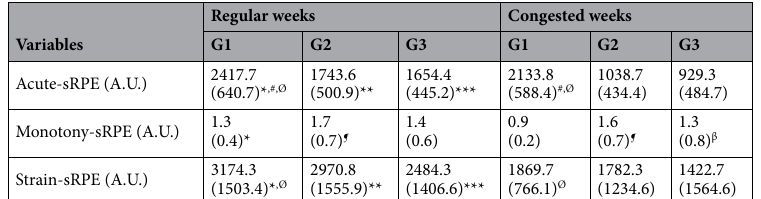
Table 1. Mean (standard deviation) of the acute, monotony, and strain indices for the rate-of-perceived- exertion-based training load (sRPE) according to congested fixture and matches’ participation. G1 = players who played ≥ 60 min; G2 = players who played < 60 min; G3 = players who did not participate of the match. * G1: Regular week > Congested week; ** G2: Regular week > Congested week; *** G3: Regular week > Congested week; # G1 > G2; Ø G1 > G3; ¶ G2 > G1; β G3 >